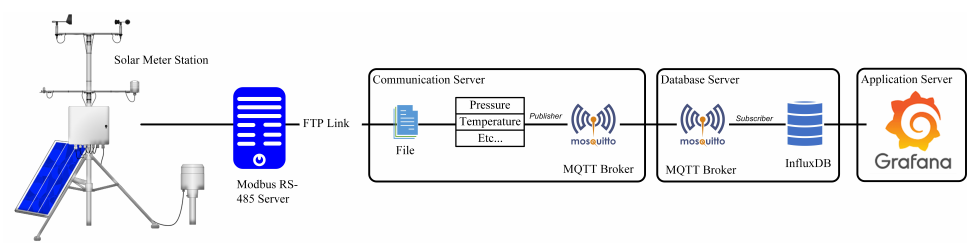
Figure 7. Schematic of the communication established between the solar meter station and the application server, showcasing the interaction between FTP, MQTT, and the